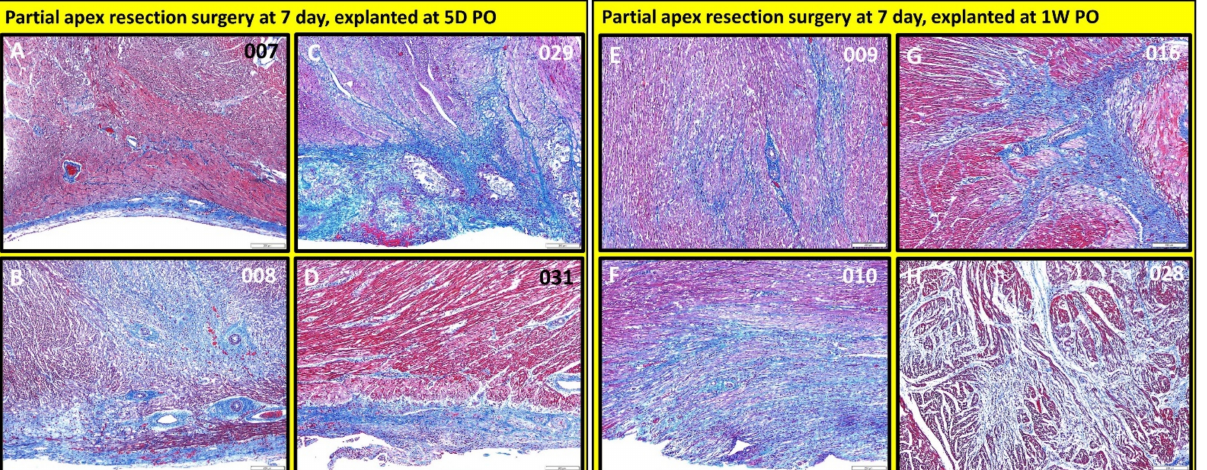
Figure 13. Partial apex resection surgery at 0 days and heart explanted at 1W PO-( A ) Hematoxylin and Eosin (H & E) histology 0-day surgery heart explant obtained one week post-operation (1W PO) from piglet #018. Higher magnification of the field of Figure 11H reveals proliferative spindle cells with thin nuclei often oriented in stacked arrays (black arrow) that are perpendicular to capillaries (blue arrow) typical of fibrovascular tissue. The relationship to the myocardium is abrupt. ( B ) Masson’s Trichrome of the same field reveals prominent interspersed collagen (Scale bar = 50 µ m).